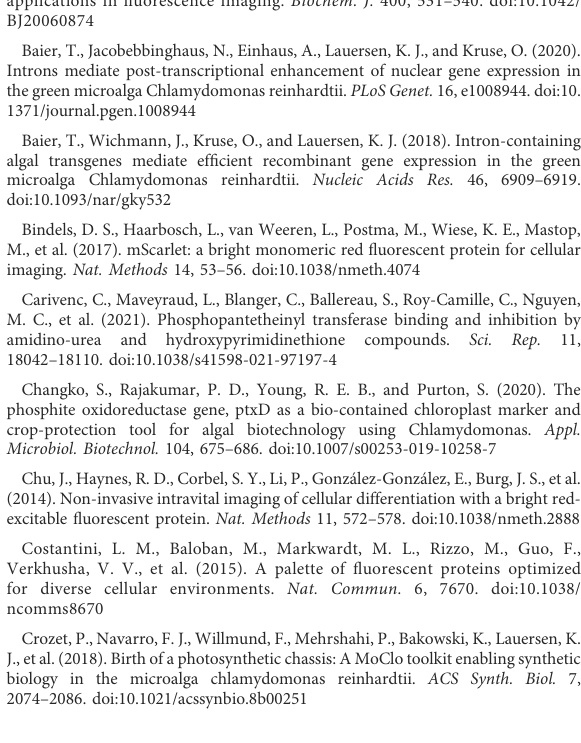
SUPPLEMENTARY FIGURE S1 Arti fi cial colored whole-plate images captured during fl uorescence screening under different fi lter sets in the Analytik Jena ChestudioPLUS for colonies of Figure 2A. fi lter sets as indicate per image. (H) — digital color camera image of agar and amido black containing plates. (B) — mTagBFP2, (C) — mCerulean3, T — mTFP1, (G) — moxGFP, LSS — LSSmOrange, Cl — Clover, Y — mVenus, KO — mKOk, Sc — mScarlet, R — mRuby2, N, mNeptune2.5, P — Parent strain (furthest right column as SUPPLEMENTARY FIGURE S4 Raw images of whole-plate fl uorescence screening under different fi lter sets for the streaked colonies in Figure 2B. C. reinhardtii cells expressing